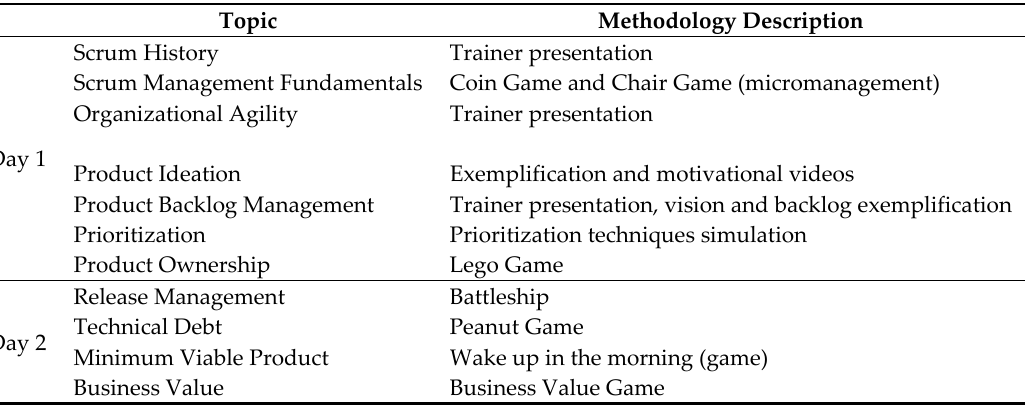
Table 2. Product Owner Workshop